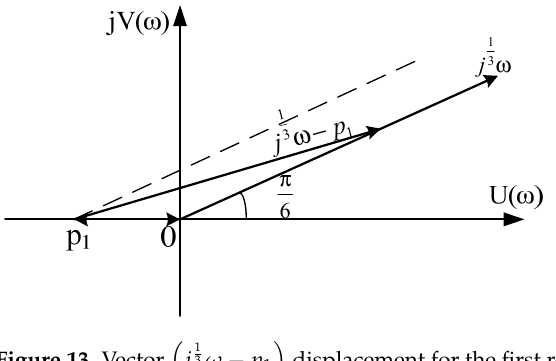
(cid:16) (cid:17) j 1 3 ω − p 1 Figure 13. Vector displacement for the first root when ω (cid:101) ( 0, ∞ ) (cid:3117) Figure 13. V ector (𝑗 (cid:3119) 𝜔 − 𝑝 (cid:2869) ) displacement for the first root when 𝜔 𝜖 (0, ∞) .